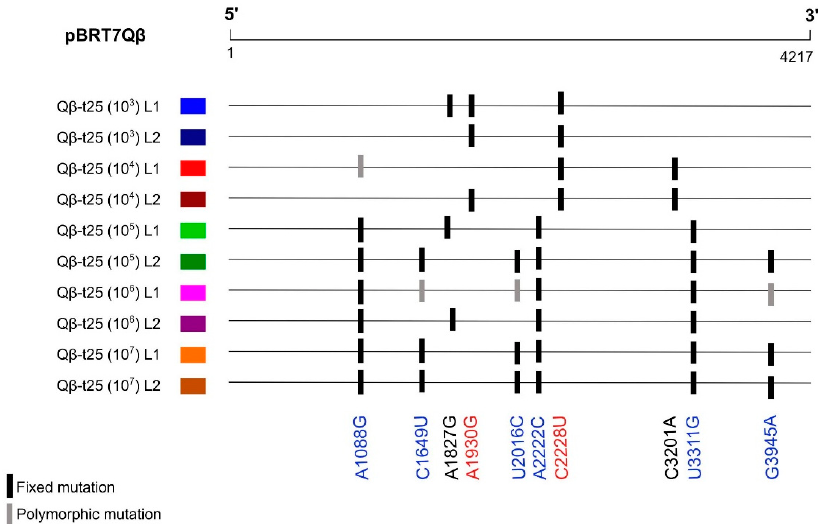
Figure 3 . Mutations present in the consensus sequences of two or more of evolutionary lineages propagated at 43 ◦ C from Q β -t25 (see Figure 2a). A complete list of all the mutations in these populations is shown in Table S2. Mutations in red correspond to those more represented in the evolutionary lineages propagated at small transmission bottlenecks (10 3 and 10 4 pfu), whereas those in blue were the most frequent when the transmission bottleneck was larger ( ≥ 10 5 pfu).